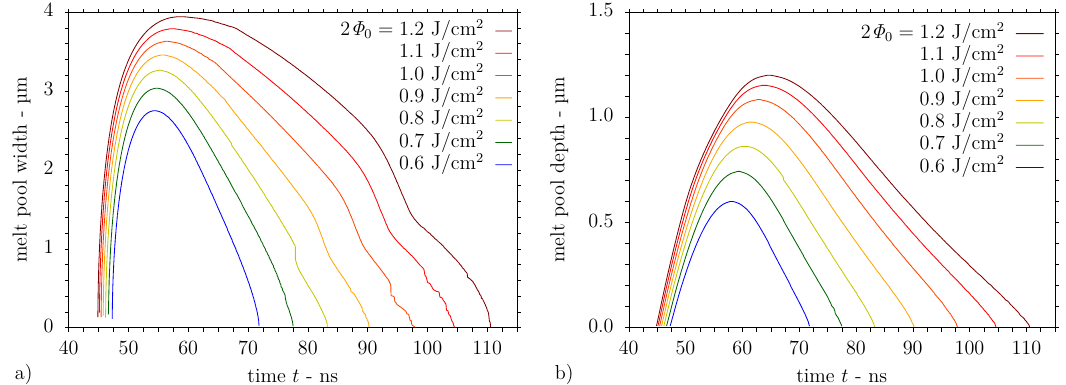
Figure 9. Evolution of melt pool dimensions during single pulse DLIP of high-purity aluminium as determined by the SPH model for different laser fluences: ( a ) melt pool width and ( b ) melt pool depth.